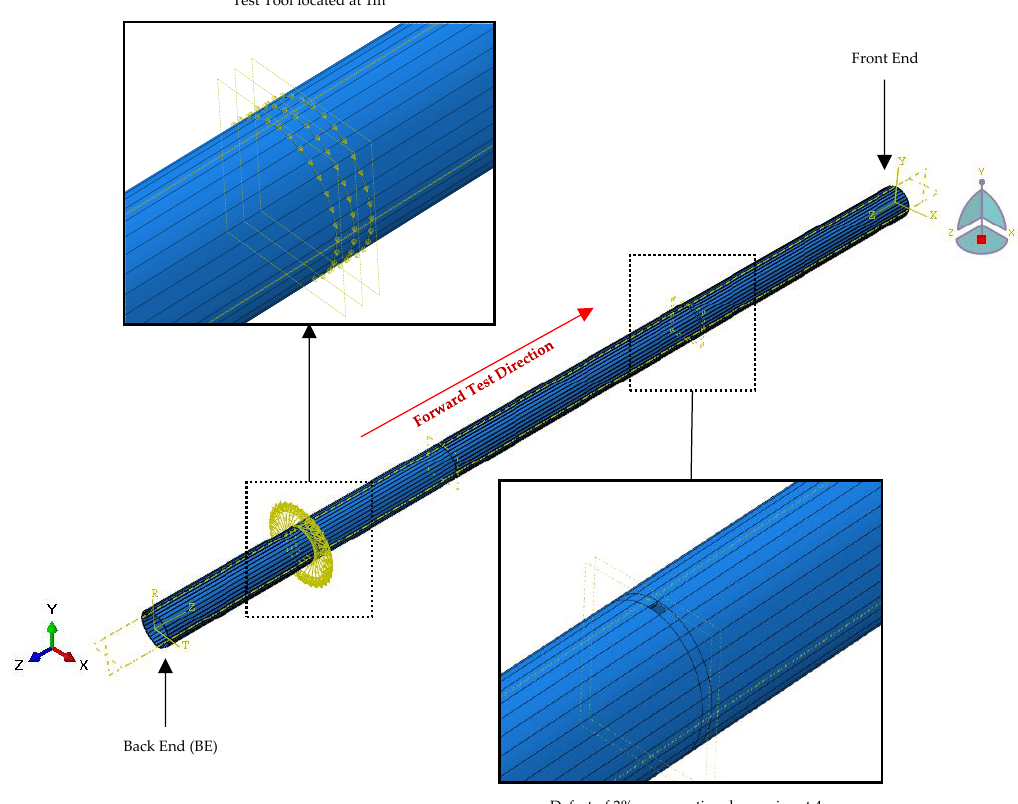
Figure 6. Schematic of the FEM with test tool and defect located at 1 m and 4 m, respectively, from the back end [31].